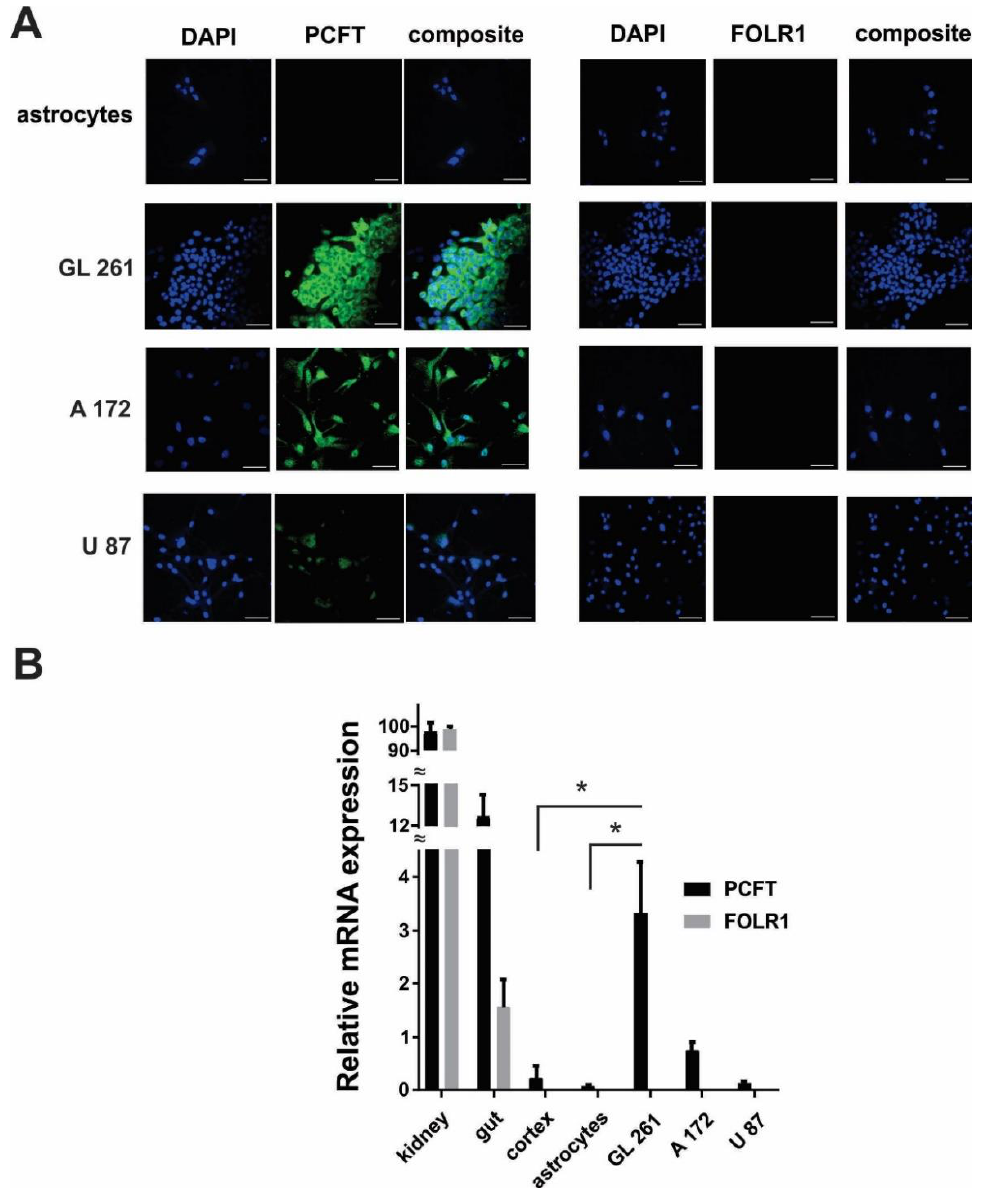
Figure 4. Proton-coupled folate transporter (PCFT) expression in GL261, A172, U87 glioma cells and mouse cultured primary astrocytes. ( A ) Confocal images showing immunofluorescent detection of the PCFT and folate receptor 1 ( FOLR1) in glioma and astrocytic cells. DAPI (4′,6-diamidino-2-phenylindole) was used to stain the nuclei of cells. Scale bar, 50 µm. ( B ) Relative gene expression for PCFT and FOLR1 in astrocytic, U87, A172, GL261 cells, as well as in cortex, gut and kidney tissues in mice. Data are normalized to glyceraldehyde 3-phosphate dehydrogenase (GAPDH) as housekeeping gene. Mean ± SEM, significant differences from control (*) are shown ( p < 0.001). N = 3 ( N is the number of the experimental repeats per cell culture. In the case of tissue samples (kidney, gut, cortex) N is the number of tissue samples; each sample was analyzed in triplicate).